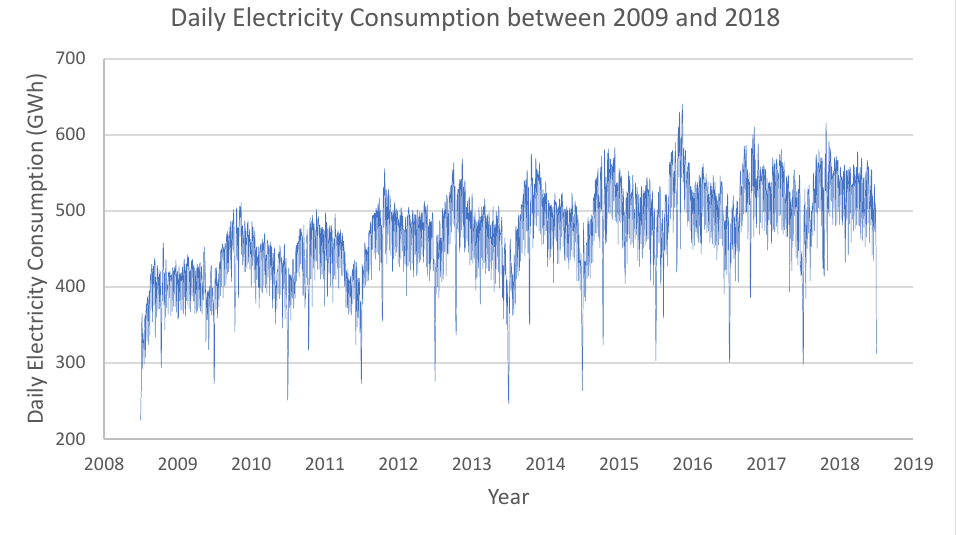
Figure 5. Daily electricity consumption in Thailand 2009–2018. Five moving average MA( L ) variables, including MA(7), MA(30), MA(90), MA(120), and MA(365), are created. MA(7) is a weekly moving average with a span of seven days. Similarly, MA(30), MA(90), MA(120), and MA(365) are monthly, quarterly, seasonally (Thailand has three seasons, each of which spans approximately four months), and yearly moving averages, respectively. Seasonal index (SI) variables are estimated for each month in each year. MA and SI are computed using Equations (14) and (15):